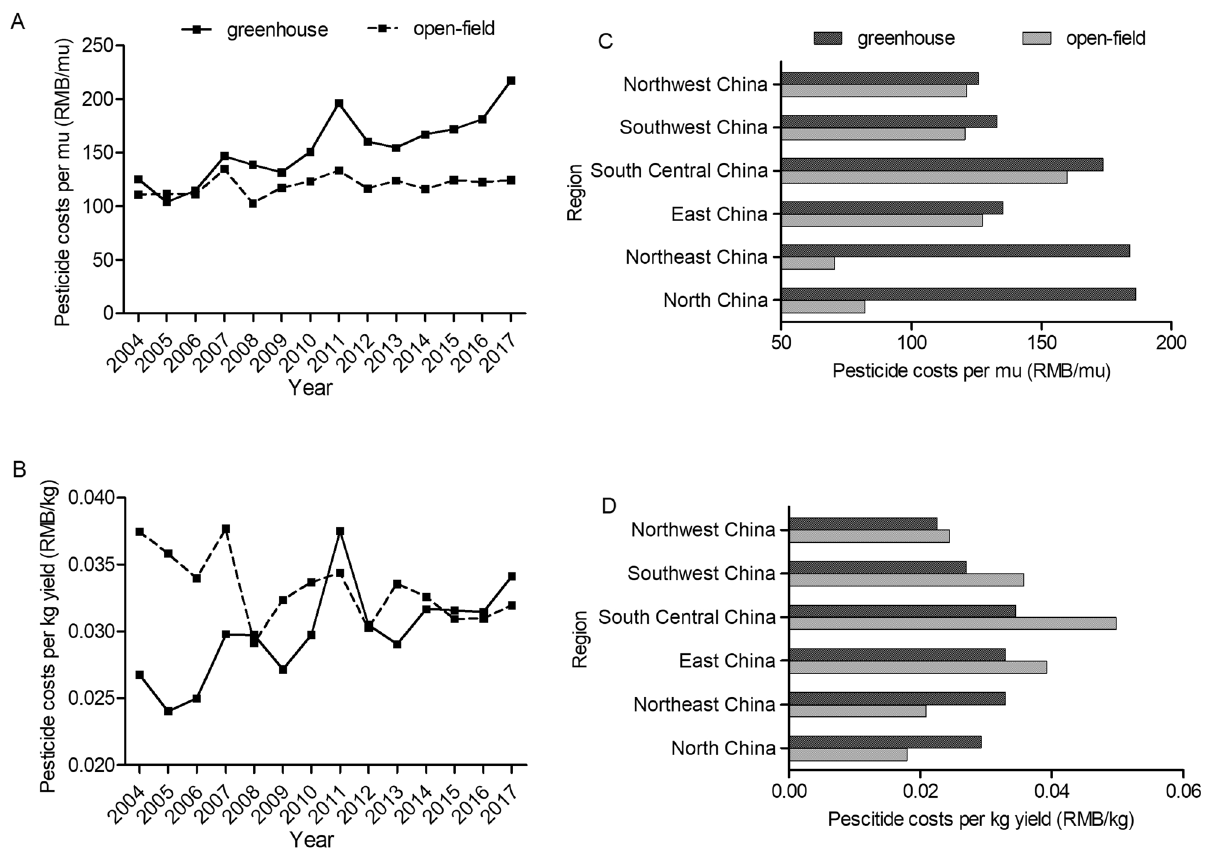
Figure 5. Costs of organic fertilizers on greenhouse and open-field cucumbers. ( A ) and ( B ) presented costs of organic fertilizers per mu and per kg yield during 2004–2017, respectively. ( C ) and ( D ) presented the average values of organic fertilizers costs (per mu and per kg yield, respectively) across six regions in vegetables imply that greenhouse vegetables do not have higher overuse degrees of chemical fertilizer than open-field vegetables. The results in this part furtherly document that greenhouse vegetables do not have lower allocation efficiency for chemical fertilizers than open-field vegetables with vegetables’ sale price and yield into consideration. Therefore, the serious pollution caused by agrochemicals in greenhouse vegetables may attribute environment pollutions could be significantly alleviated in greenhouse production system if farmers just take advantage of the function to provide controlled growing conditions during off-season rather than year-round production. One possible policy implication is that reducing the number of production rotations may be an effective method to alleviate the overuse of agrochemicals used in greenhouse vegetables. To produce more and more vegetables, farmers not only use the greenhouse to provide the regulated and controlled growing conditions in off-season but also produce vegetables in the other seasons. We found that more and more farmers use greenhouse to grow only one season of tomato per year in off-season to protect the soil quality in the south of Jiangsu province. In addition, to balance environment protection and vegetable production, modern farming